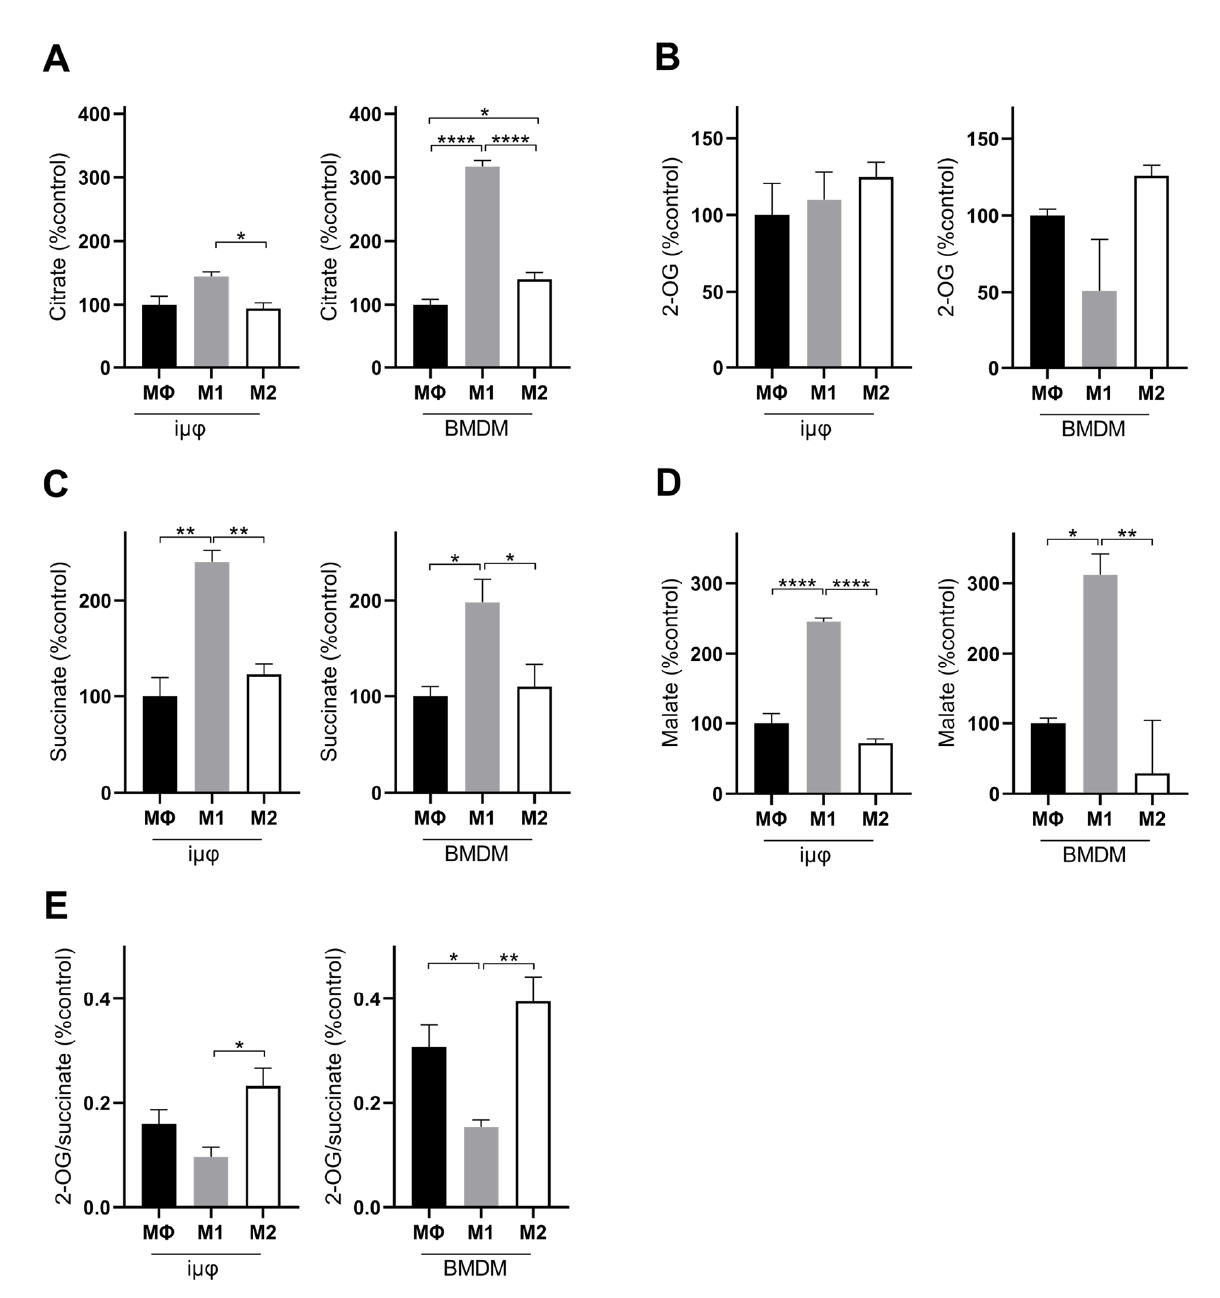
Figure 5. M1- and M2-stimulated i µ Φ and BMDM macrophages display similar features for TCA metabolites. LC-MS/MS quantification of citrate ( A ), 2-OG, ( B ), succinate ( C ), malate ( D ) and 2-OG/succinate ratio ( E ) in M Φ -, M1- and M2- stimulated i µ Φ ( n = 3) or BMDM cells ( n = 3). Data are means ± SEM. * p < 0.05, ** p < 0.01, **** p < 0.0001.